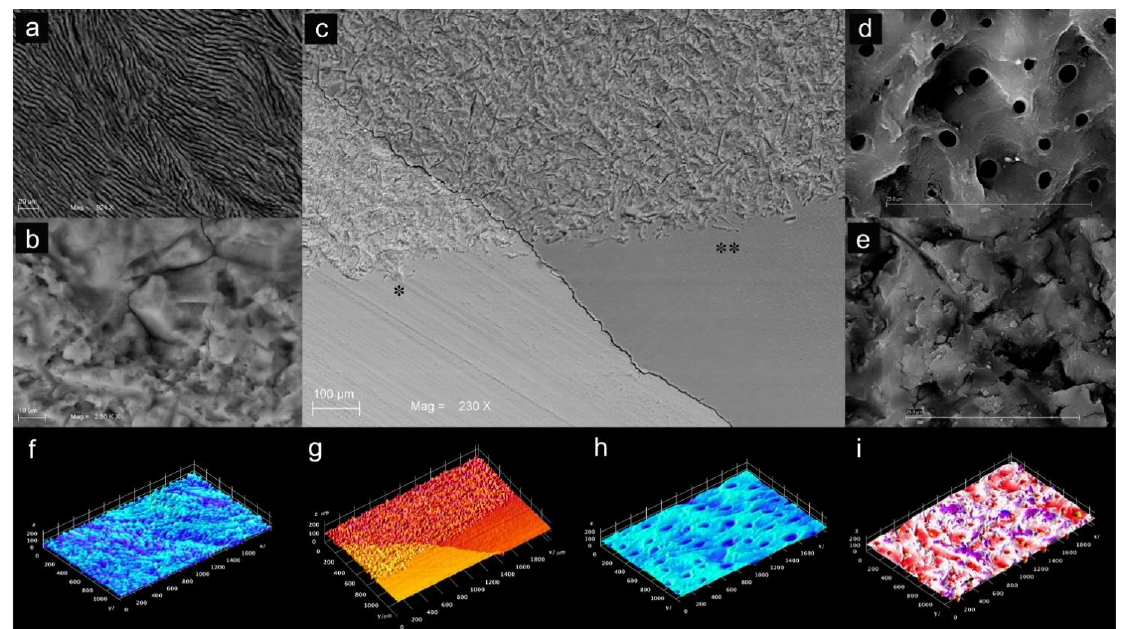
Figure 7. Comparison between SEM images of enamel and dentin after WAPA and acid-etching: ( a ) enamel prisms after WAPA procedure and acid-etching. Mag. 924×; ( b ) enamel after WAPA procedure before acid-etching. The WAPA procedure introduce a 3D dimension to the surface. Mag. 2500×; ( c ) enamel ( * ) and dentin ( ** ) with WAPA procedure (top side) and without WAPA procedure (bottom side). Mag. 230×; ( d ) dentin after WAPA procedure and acid-etching. Several dentin tubules appeared open on dentin surface with different directions. Mag 2500×; ( e ) dentin after WAPA procedure before acid-etching. Mag. 4000×; ( f ) 3D reconstruction of enamel roughness after WAPA and acid etching procedures. The Ra was 150 ± 35 µm; ( g ) 3D reconstruction of the surface roughness of enamel (brighter orange side) and dentin (darker orange side) treated with WAPA procedure (top side) and without WAPA procedure (bottom side); enamel treated with only acid etching showed a Ra of 98 ± 24 µm; ( h ) 3D reconstruction of the surface roughness of dentin treated only with acid-etching. The Ra was of 102 ± 27 µm; ( i ) 3D reconstruction of the surface roughness of dentin after WAPA and acid etching procedures. The surface Ra was of 160 ± 25 µm.